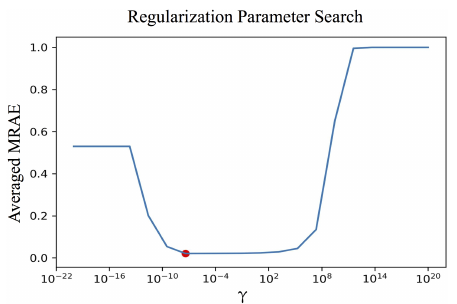
Figure 3. An illustration of searching for the regularization parameter. The averaged MRAE (vertical axis) is calculated over the validation set (a separate data set that is not the training set). The red dot in the graph indicates the minimal error and the suggested regularization